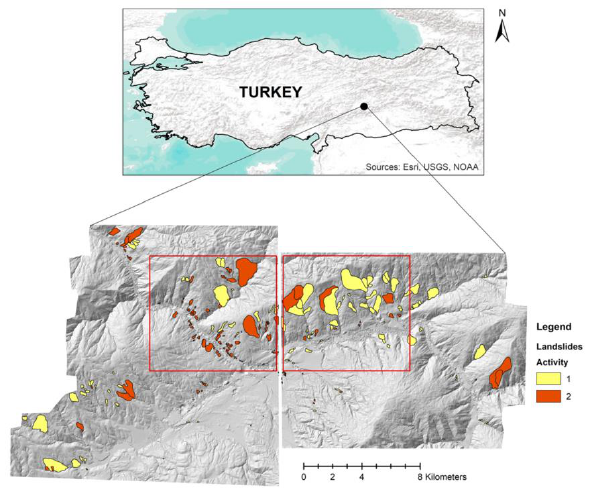
Figure 2. Location and landslide inventory maps of the study area obtained from Karakas et al. (2021a). Activity type denotes inactive (1) and active (2) mass movements.